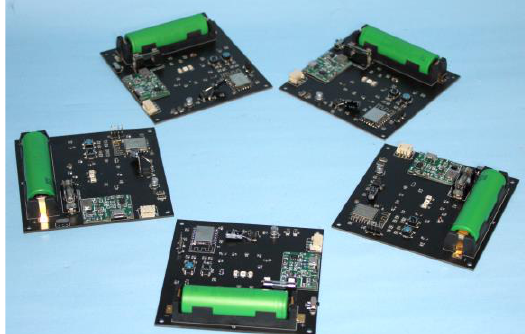
Figure 8. UV Targets developed for the calibration-pro- cedure